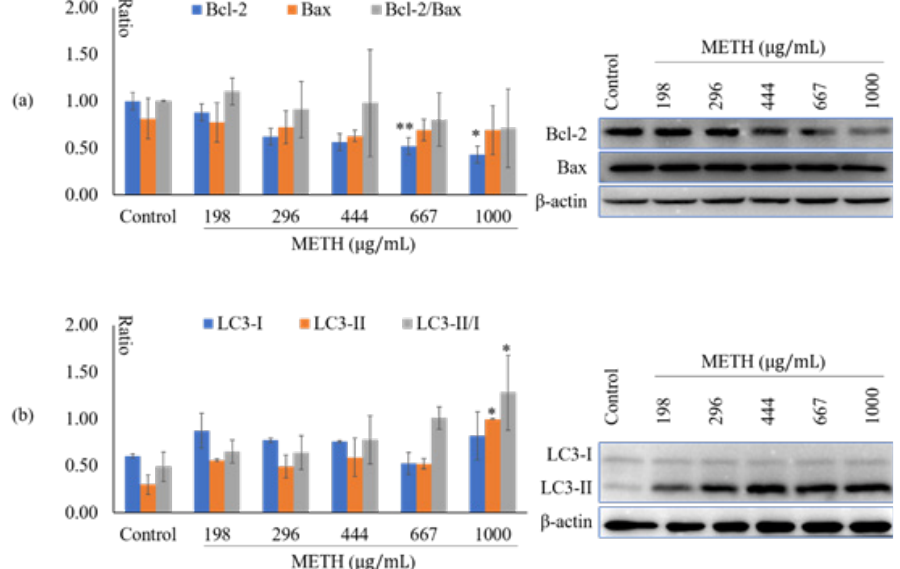
Figure 4: METH induced apoptosis and autophagy of U-118 MG cells. (a) the expression of Bcl-2 and Bax; (b) the expression of LC3. The annotation * indicates a p value < 0.05 versus control group. The annotation ** indicates a p value < 0.01 versus control